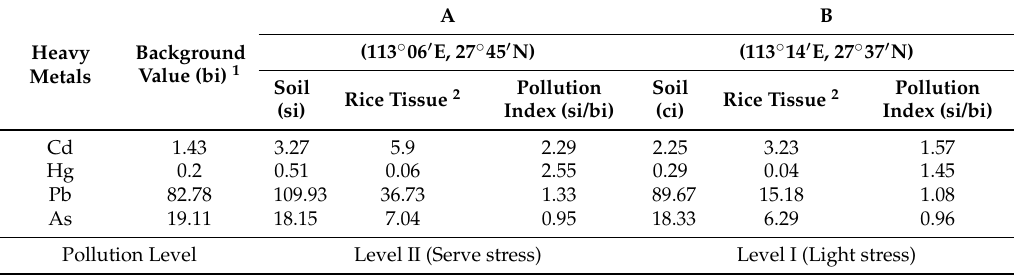
Table 1. The mean red soil of top layer and rice heavy metal concentrations in the two study